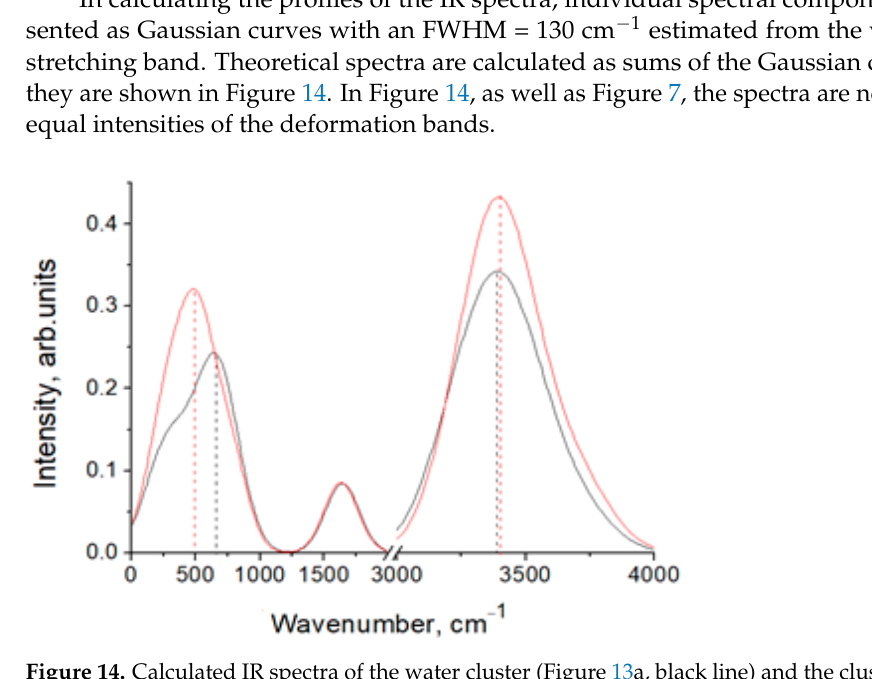
Figure 14. Calculated IR spectra of the water cluster (Figure 13a, black line) and the cluster of sodium chloride solution with maximum concentration (Figure 13b, red line).